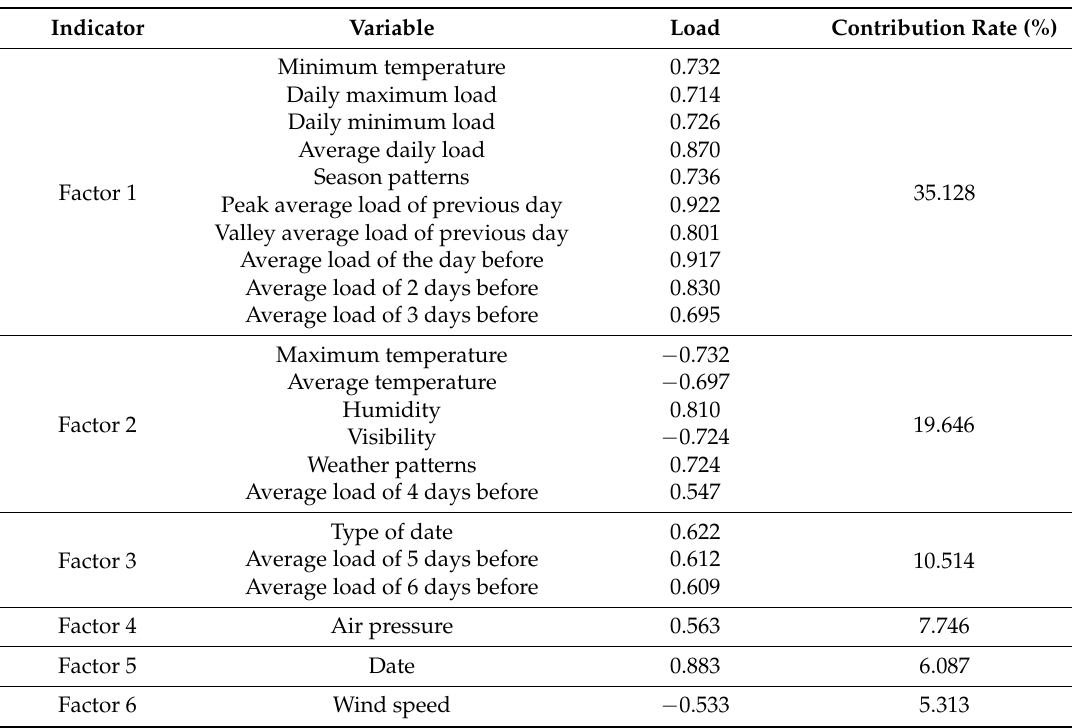
Table 2. Results of factor